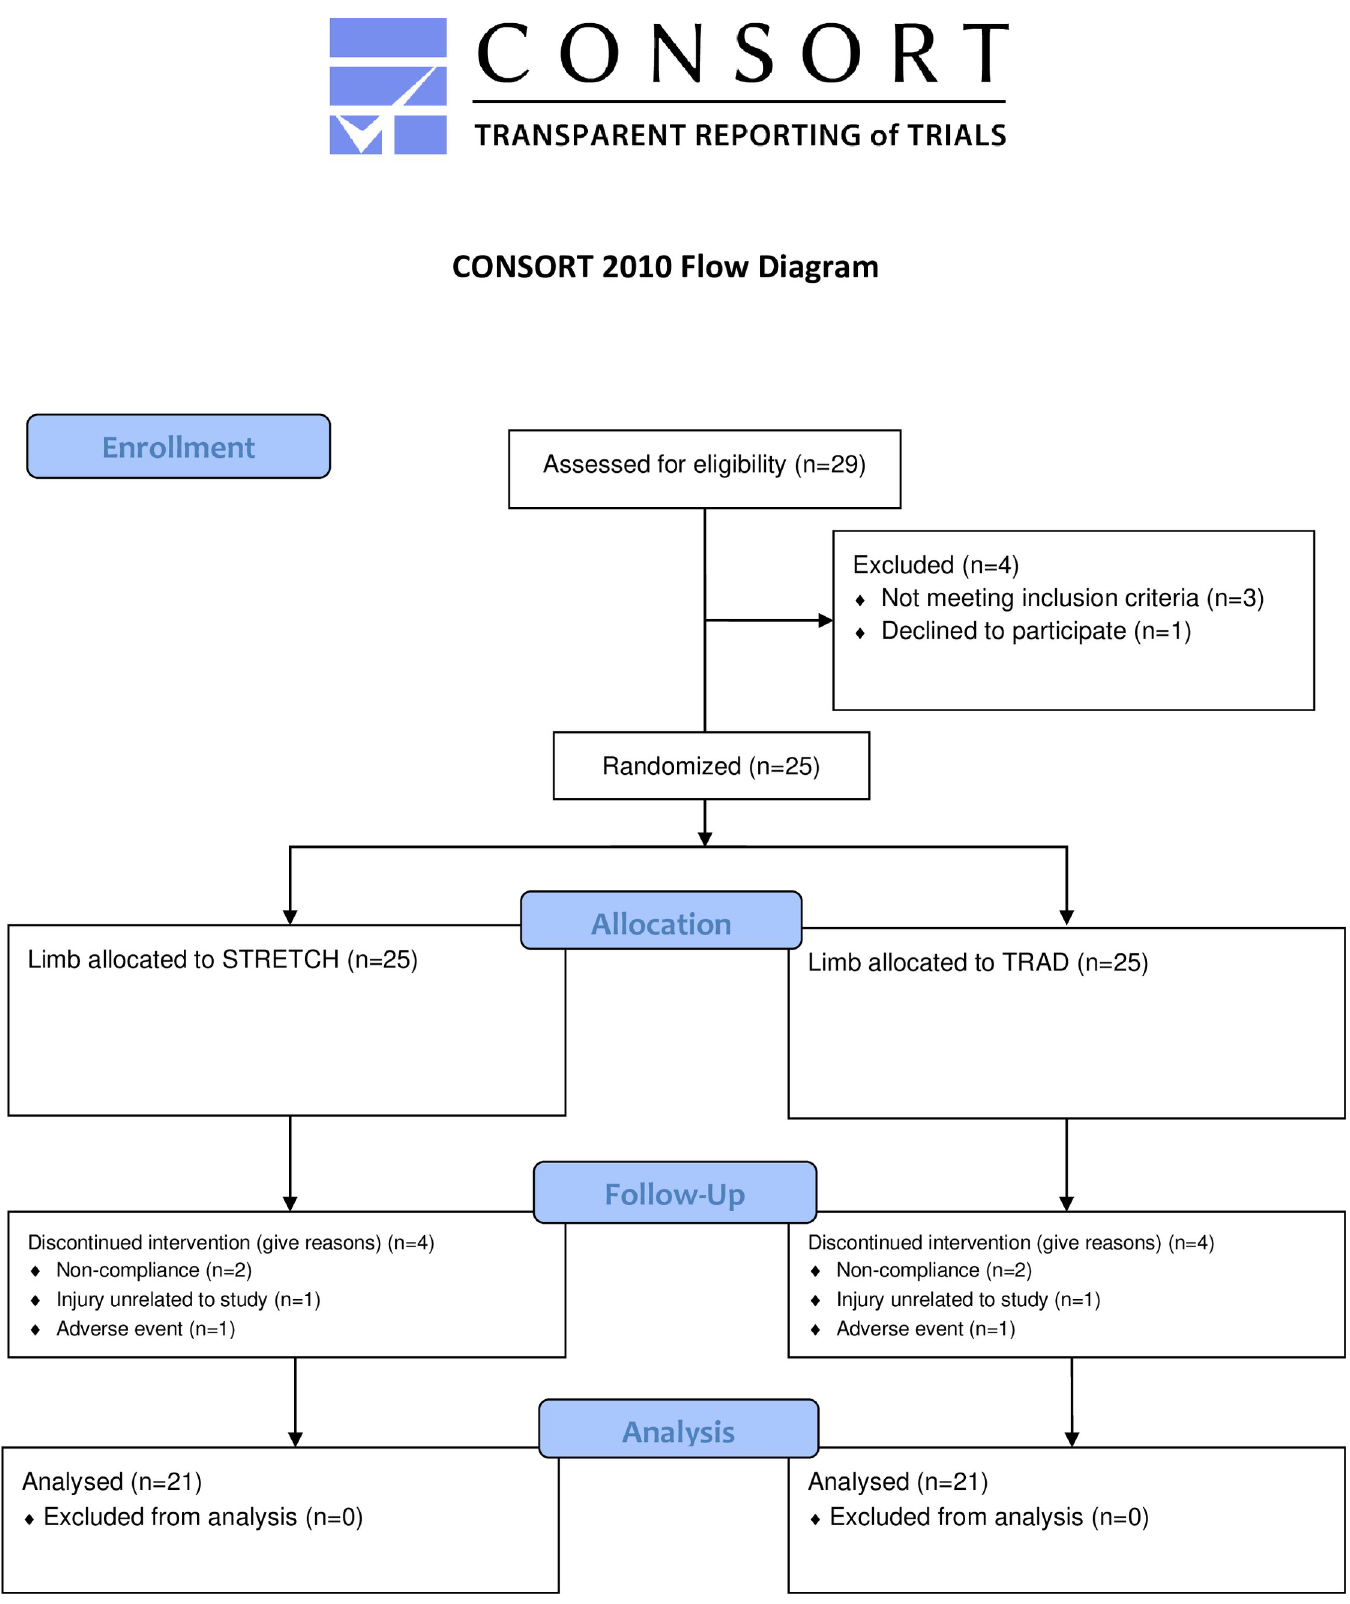
Fig 3. Consort diagram. Flow chart illustrating the data collection process.